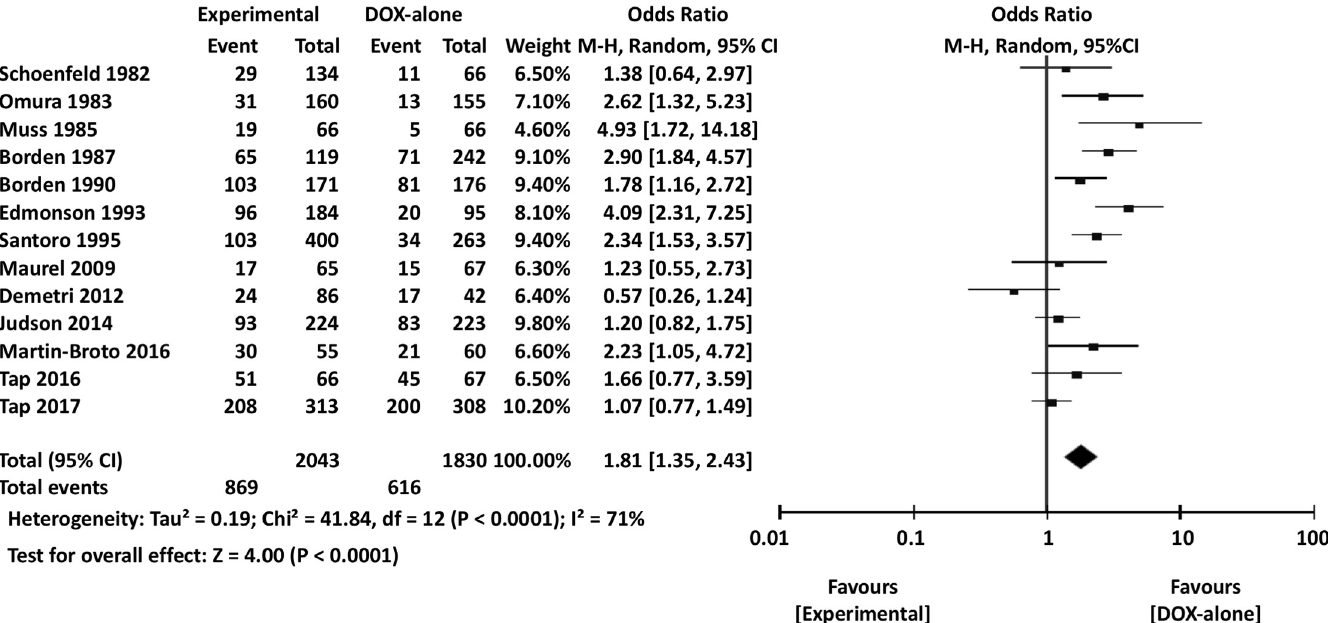
Fig 11. Comparisons of doxorubicin alone vs doxorubicin-based combination chemotherapy: Forest plots of the overall incidence of severe adverse events. M-H, Mantel-Haenszel; CI, confidence interval.